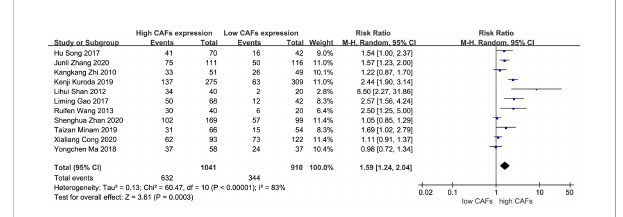
FIGURE 2 High expression of CAFs is associated with stage III – IV gastric cancer. CAF, cancer-associated fi broblast; CI, con fi dence interval.